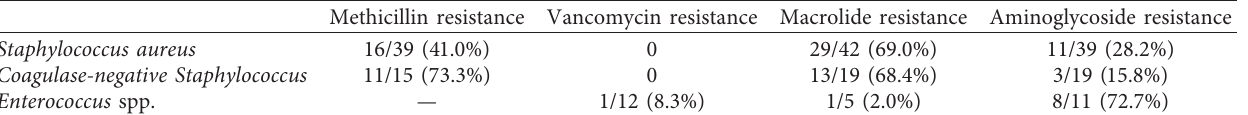
Table 4: Antibiotic resistance pattern of gram-positive